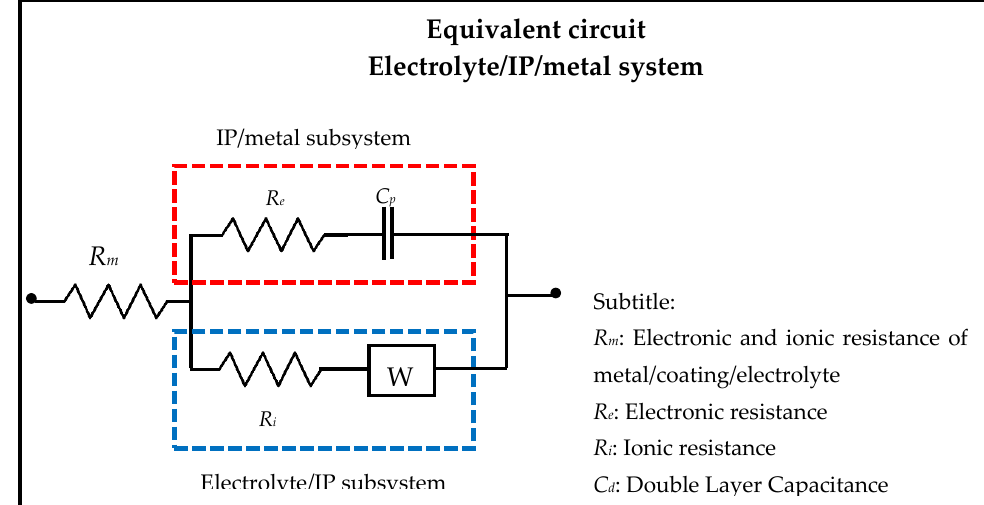
Figure 13. Equivalent electrical circuit proposed for the representation of Nyquist for Pt coated of IP of CER after 0.25 h of immersion in 2 mol L − 1 H 2 SO 4 solution.